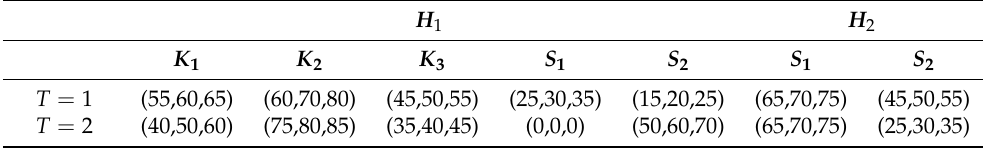
Table 3. Demand of PDPs and SDPs in different periods.